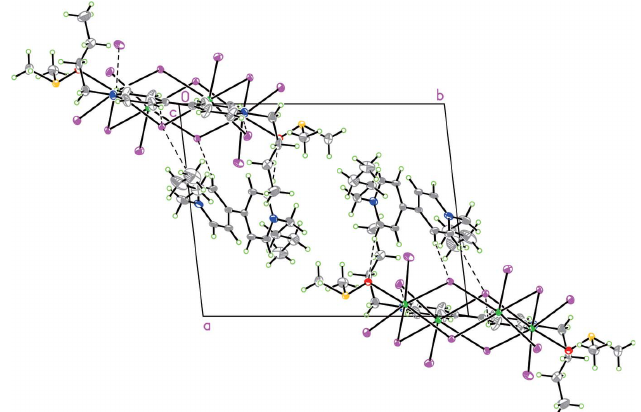
Figure 2 The crystal packing of the title compound with hydrogen bonds (Table 1) shown as dashed lines.